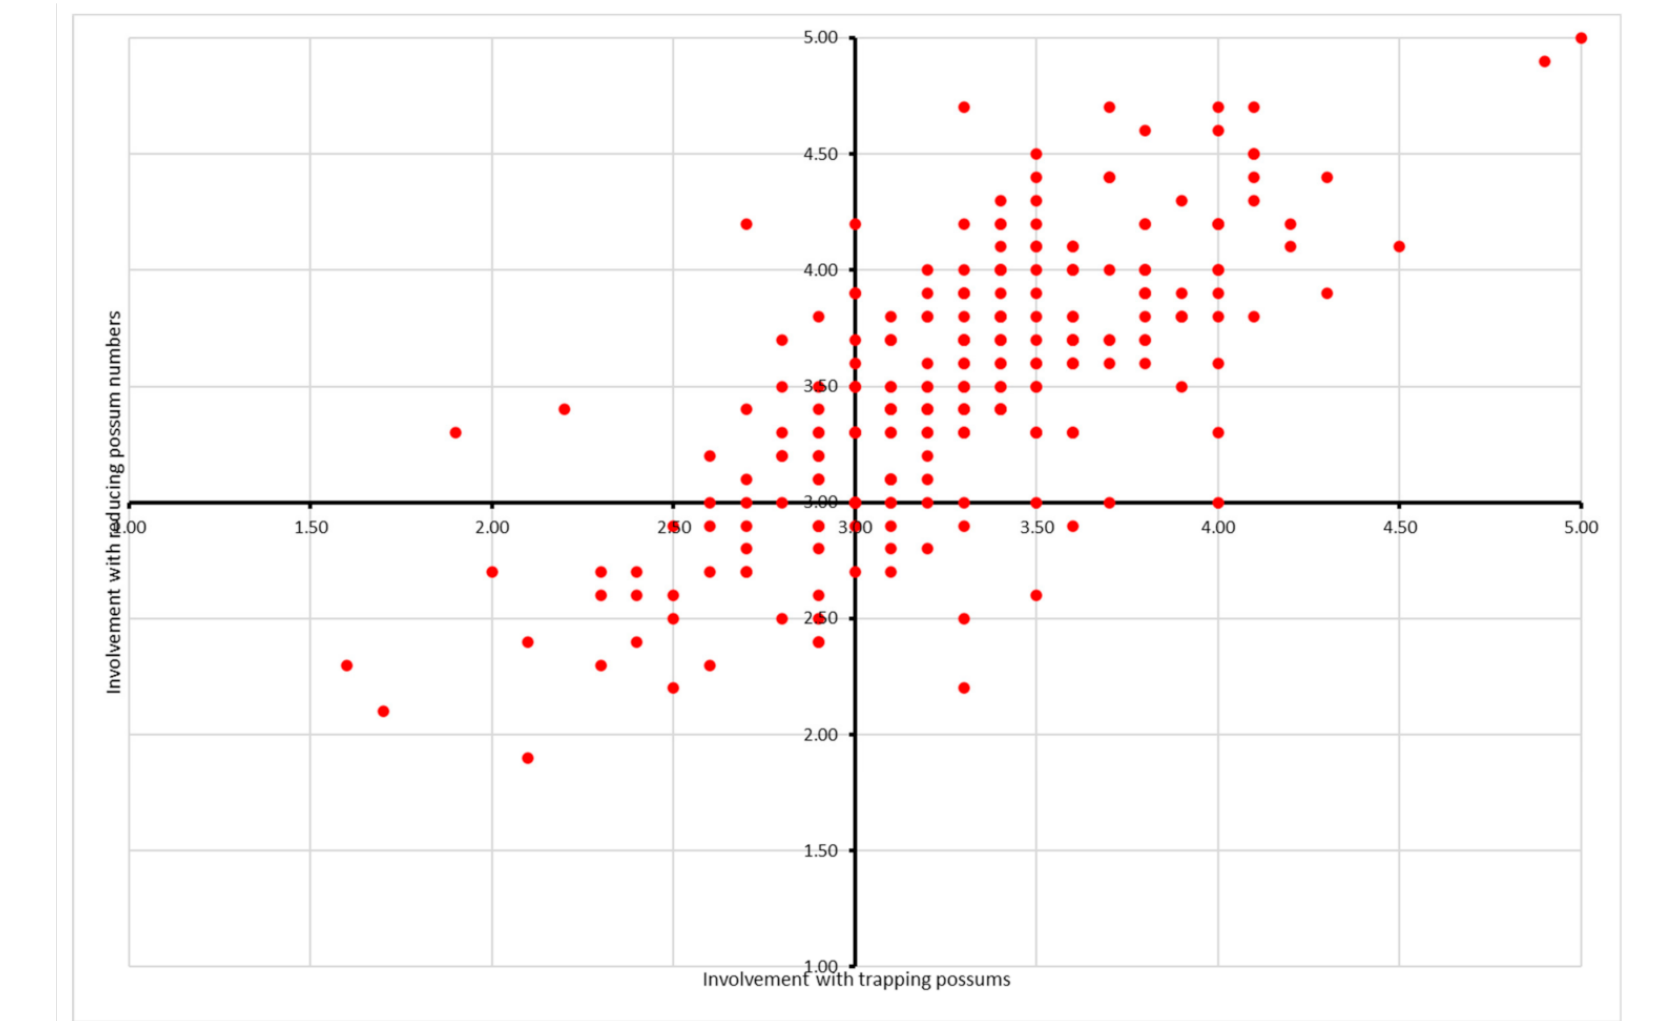
Figure 2. I 3 mapping of involvement with the idea of reducing possum numbers and the idea of using